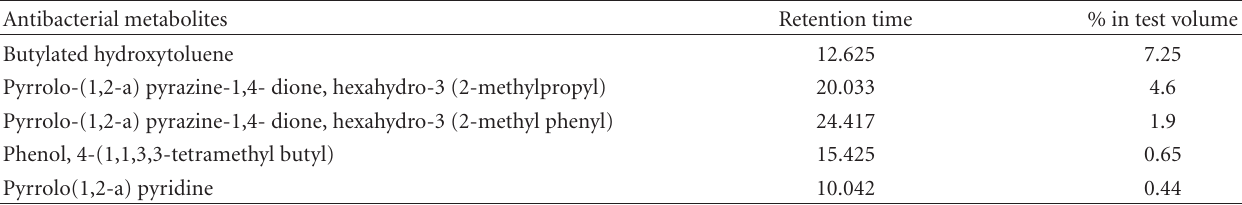
Table 2: Major antibacterial metabolites present in ethyl acetate cell extract Aeromonas hydrophila strain An4. Antibacterial metabolites Retention